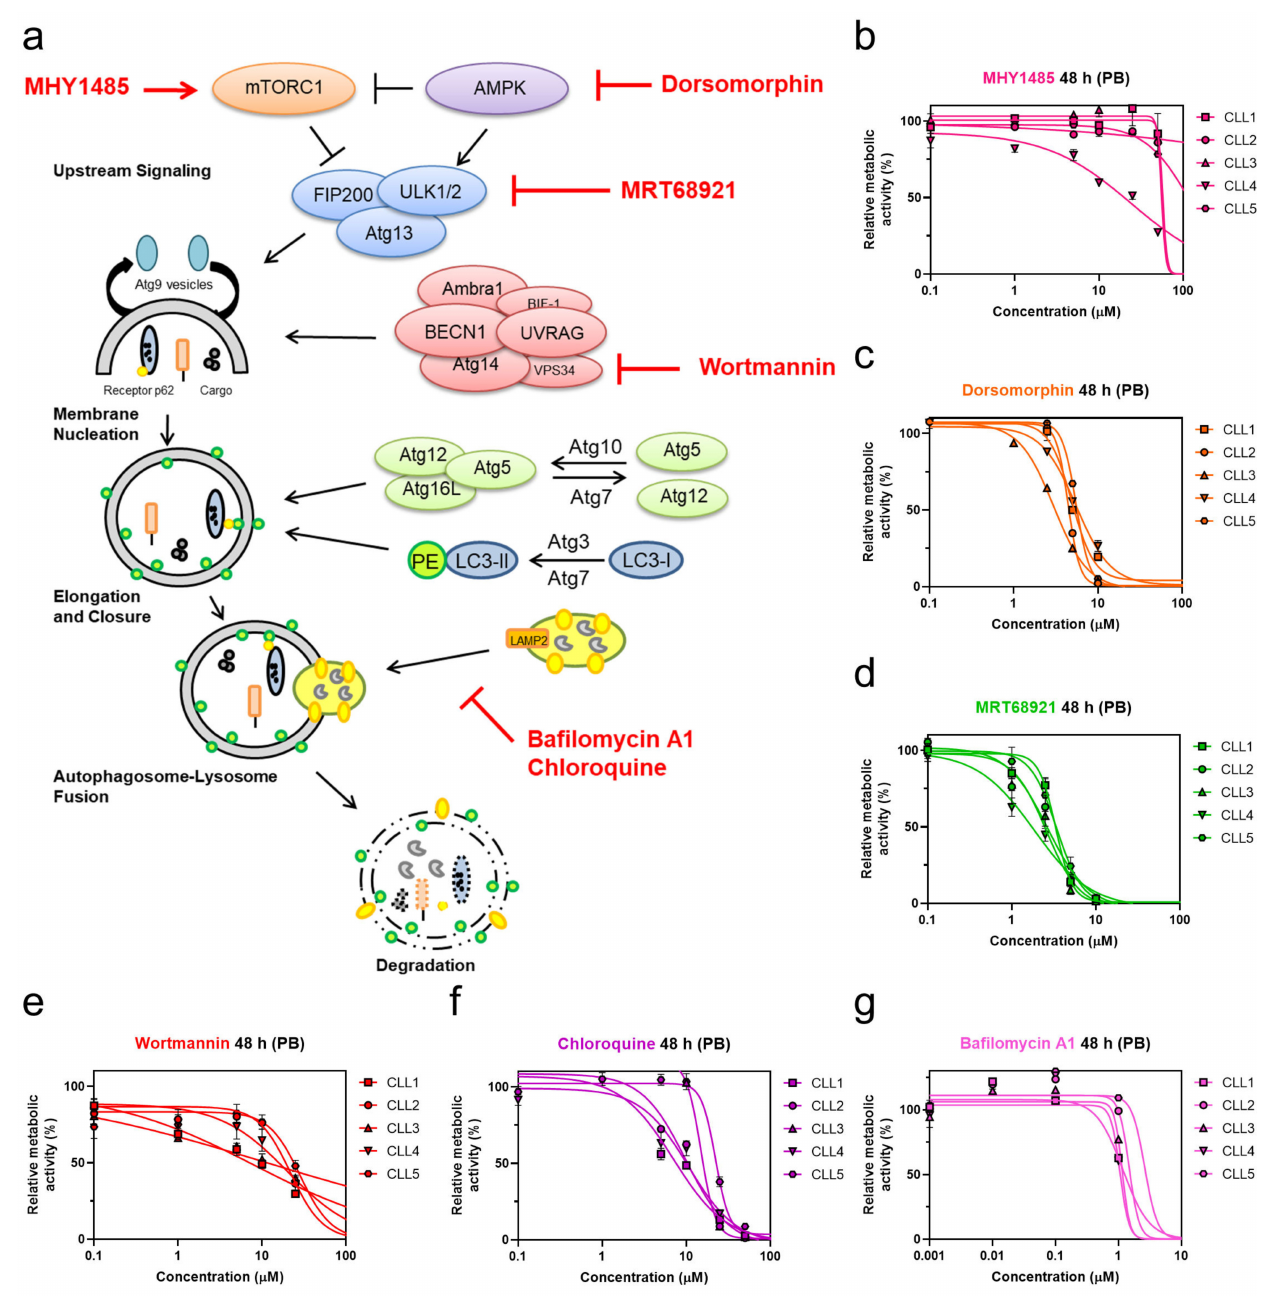
Figure 1. Targeting autophagy with distinct autophagy inhibitors induces concentration-dependent cytotoxicity in patient- derived CLL cells. ( a ) Overview of targets in the autophagic process and their pharmacological modulators; Determination of EC 50 values of autophagy inhibitors ( b ) mTOR activator MHY1485, ( c ) AMPK inhibitor dorsomorphin, ( d ) ULK1/2 inhibitor MRT68921, ( e ) PI3K class III inhibitor wortmannin, ( f ) autophagosome-lysosome fusion inhibitor chloroquine, and ( g ) late-stage autophagy inhibitor bafilomycin A1 in CLL cells derived from five patients after 48 h of treatment using the PrestoBlue (PB)